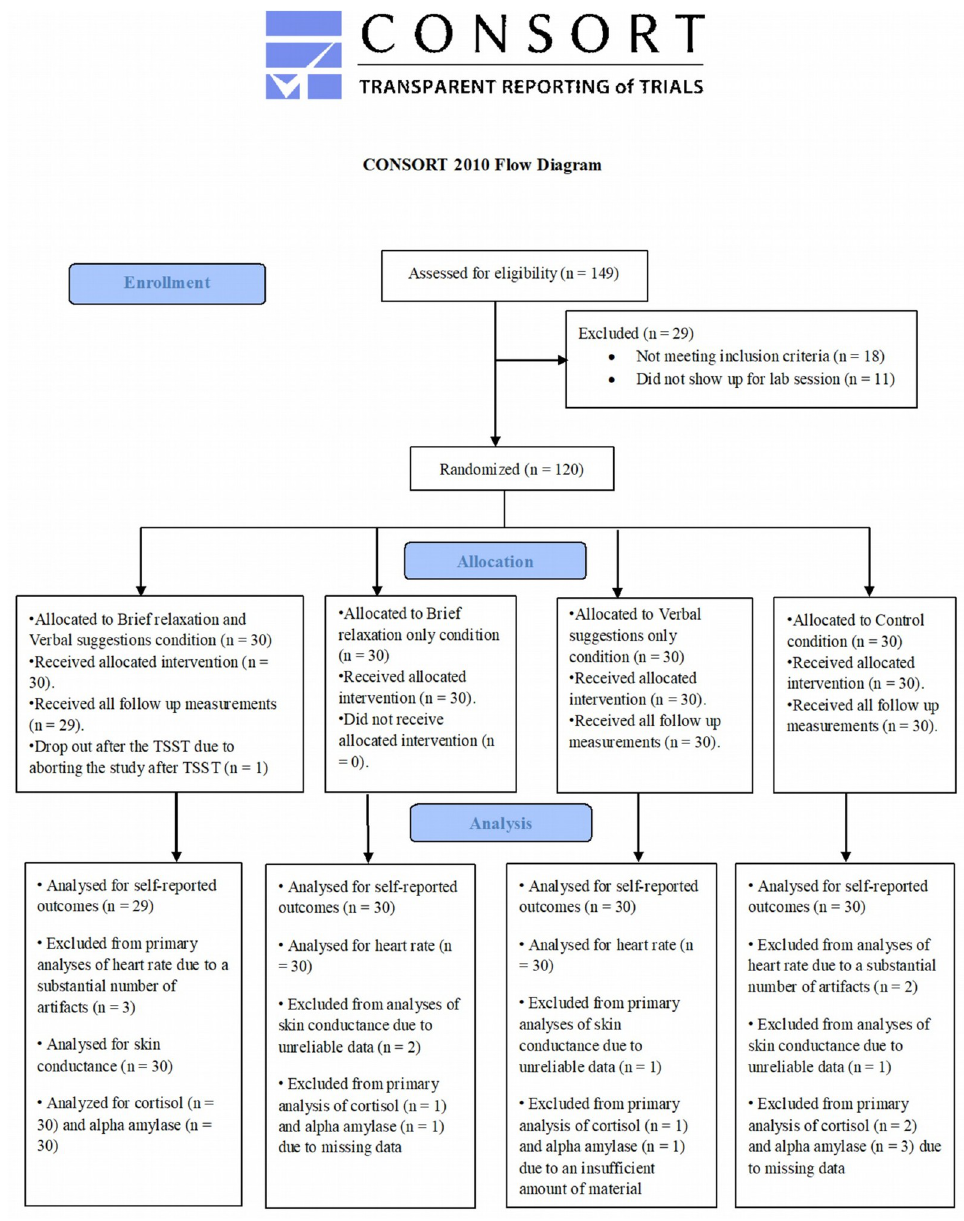
Fig 1. Flowchart of the present